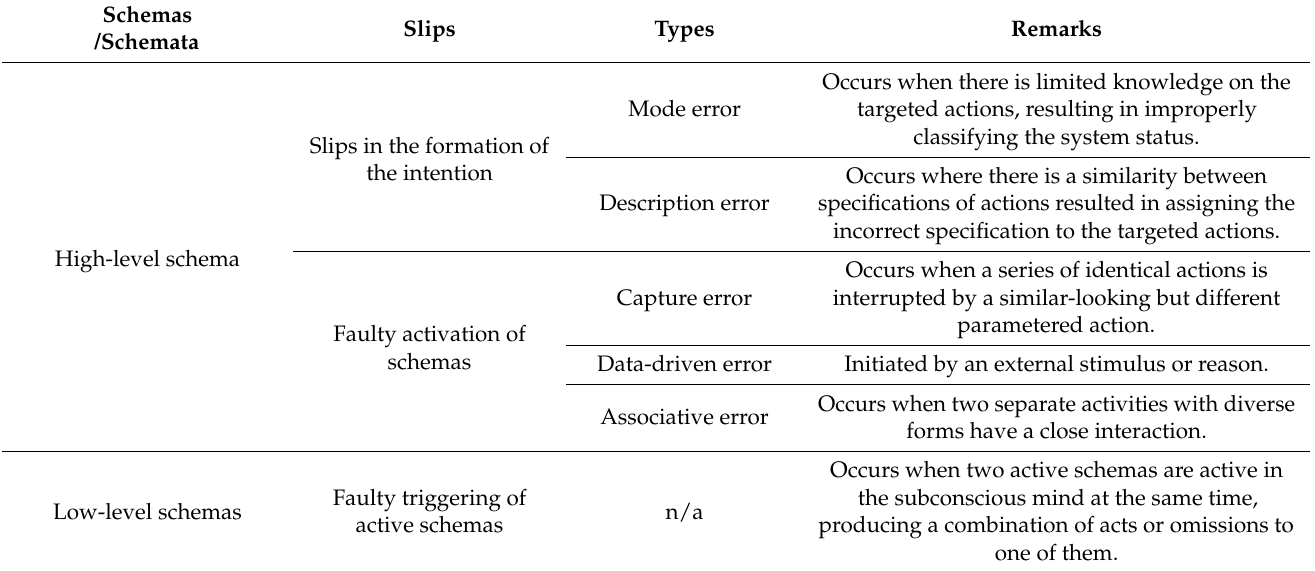
Table 2. Summary of the sources of the action slips, based on the activation-trigger-schemata system (ATS) (adapted from Norman